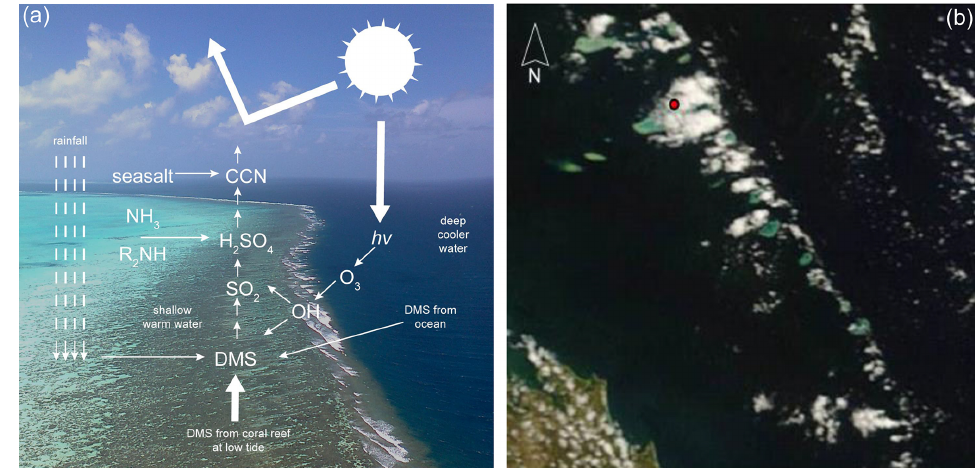
Figure 1. The Capricorn–Bunker Group of coral reefs, southern Great Barrier Reef, Australia (23.13 ◦ S, 151.85 ◦ E to 23.92 ◦ S, 152.60 ◦ E). (a) An aerial photo of Wistari Reef near Heron Island (image: H. B. Swan). Superimposed on this image is a conceptual model of factors controlling DMS a -derived sulfate aerosol production over the GBR. Ocean-derived DMS a and spikes of DMS a from the coral reef at low tide are oxidised by photochemically produced hydroxyl radical (OH) forming sulfate aerosol that can grow to cloud condensation nuclei (CCN). This process can assist formation of high-albedo low-level marine clouds that influence the radiation budget of the GBR. (b) MODIS (Moderate Resolution Imaging Spectroradiometer) satellite image of daytime low-level convective clouds aligned over the Capricorn–Bunker Group of coral reefs. Heron Island, near Wistari Reef (cloud covered), is indicated by a red circle. Part of the east Australian coastline is seen in the bottom left-hand